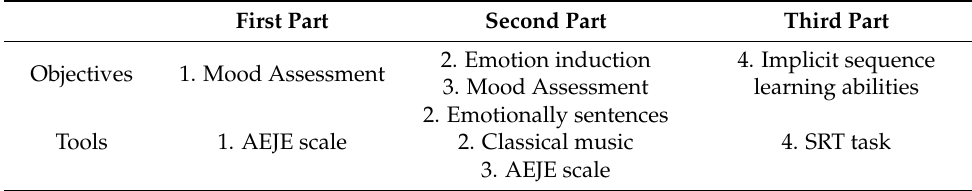
Table 1. Summary of